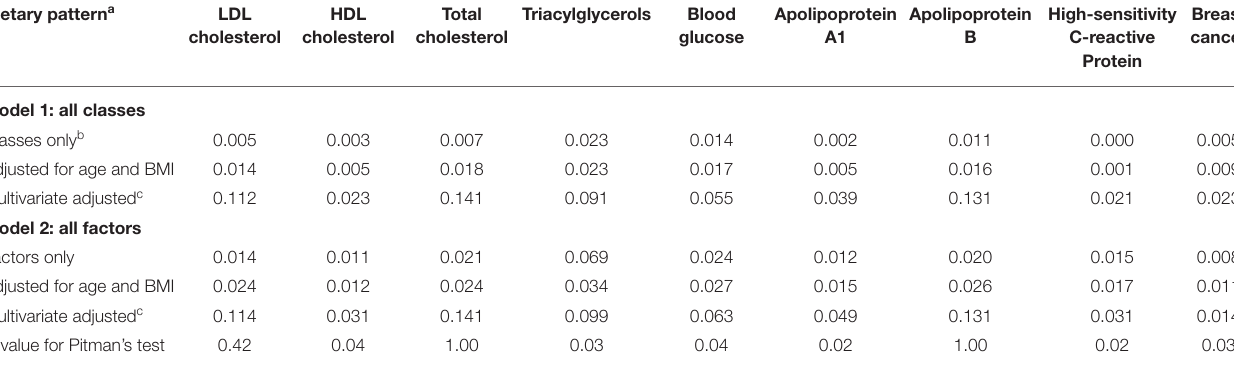
TABLE 5 | The proportion of variability explained ( R 2 ) by regression models containing all classes or all factors in predicting plasma lipid biomarkers and Pitman’s test. Dietary pattern a